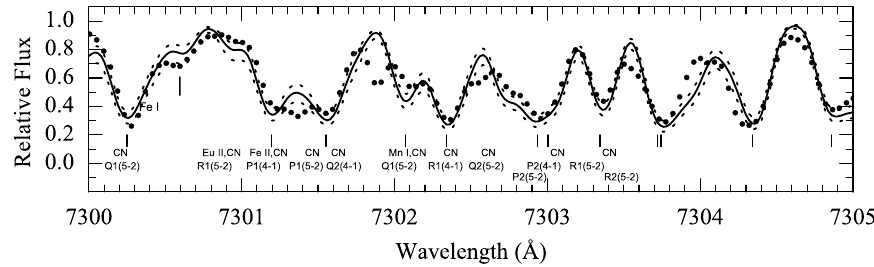
Fig. 11. The observed spectrum of HD 209621 in the wavelength range dominated by the CN Red system lines. The three synthetic CN spectra are given for the carbon abundance log ϵ (C) = 7.85, and for the nitrogen abundances log ϵ (N) = 8.00 ± 0.3.